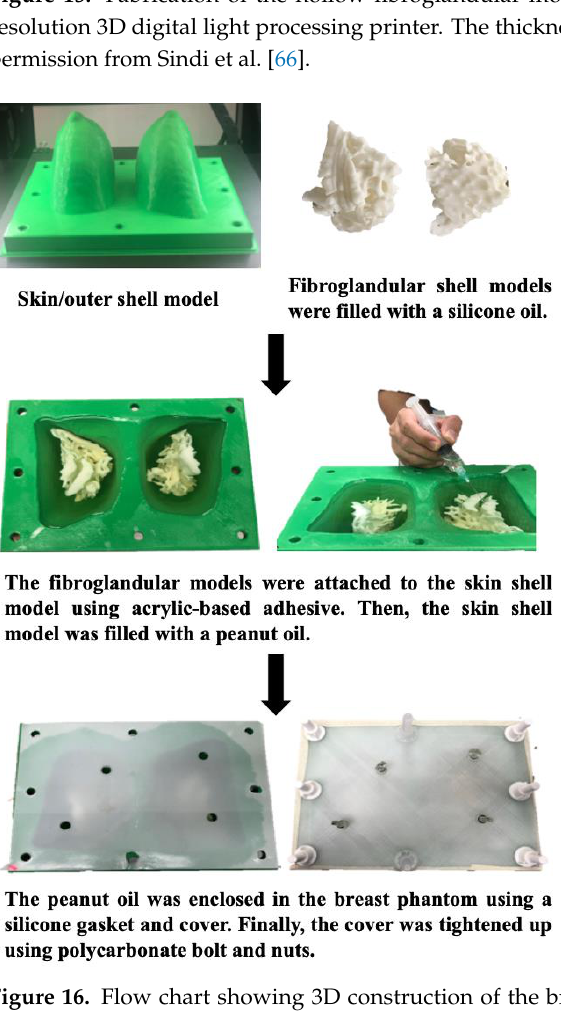
Figure 16. Flow chart showing 3D construction of the breast phantom. 3D printing was used to create the hollow shells for skin and fibroglandular regions. Fibroglandular and adipose tissues were simulated using silicone and peanut oils, respectively. Reprinted with permission from Sindi et al.